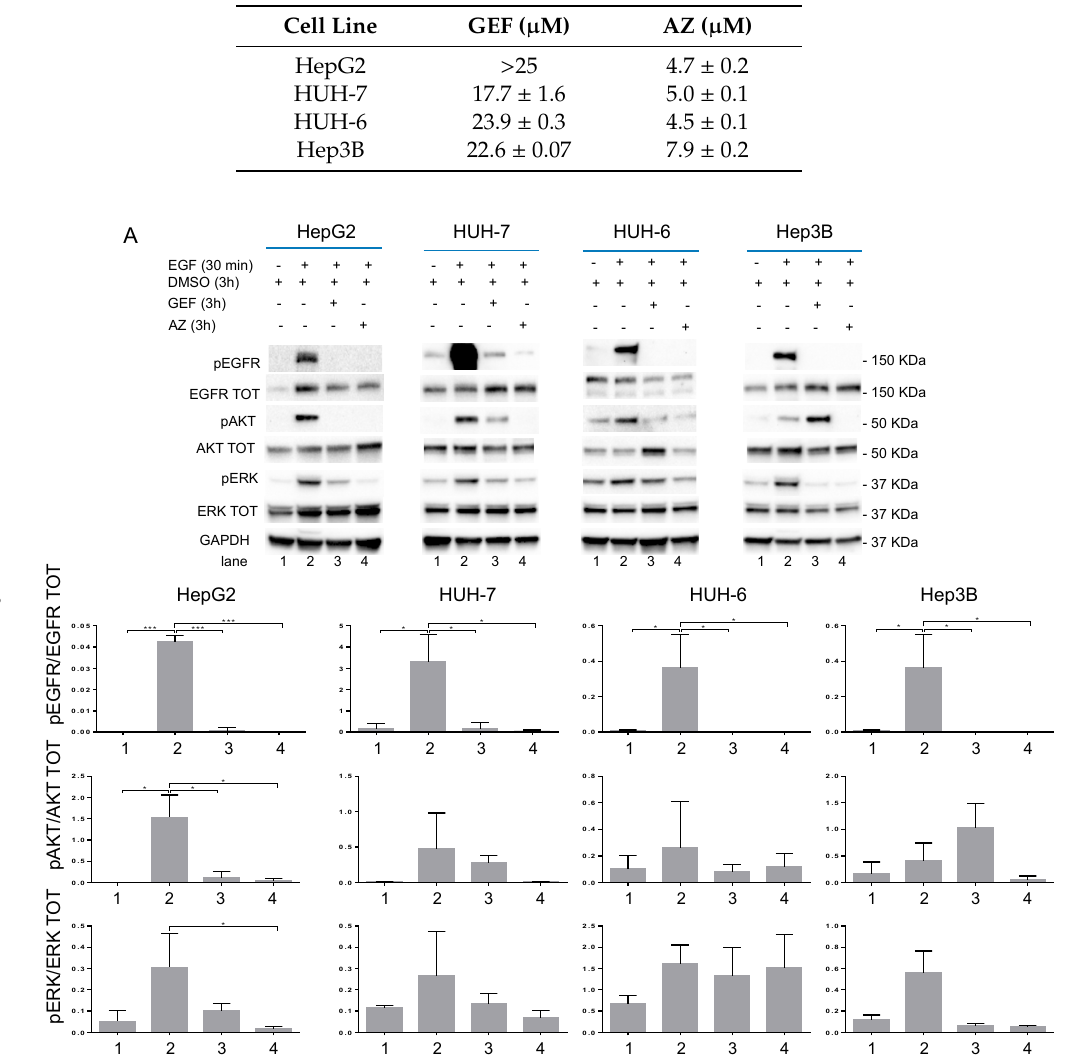
Table 1. GEF and AZ IC50 in HCC cell lines after three days incubation.